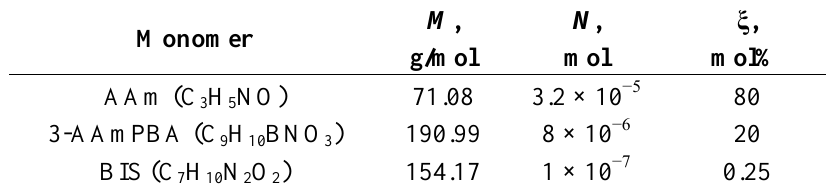
Table 2. Composition of the investigated AAm/3-AAmPBA/BIS